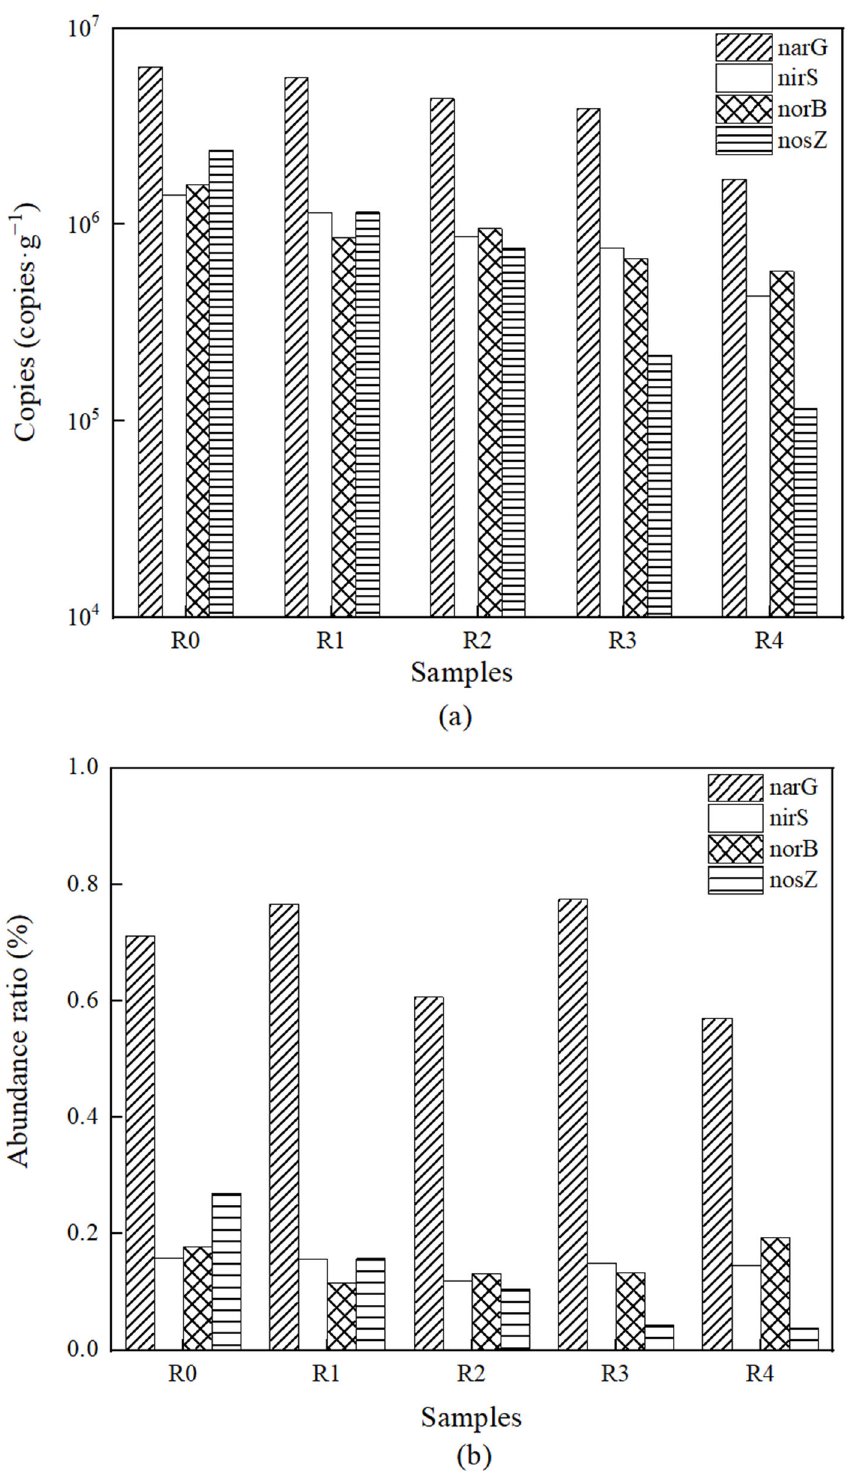
Figure 6. Effects of antibiotic stress on the abundance of denitrifying functional genes. ( a ) Absolute abundance. ( b ) Abundance ratio.